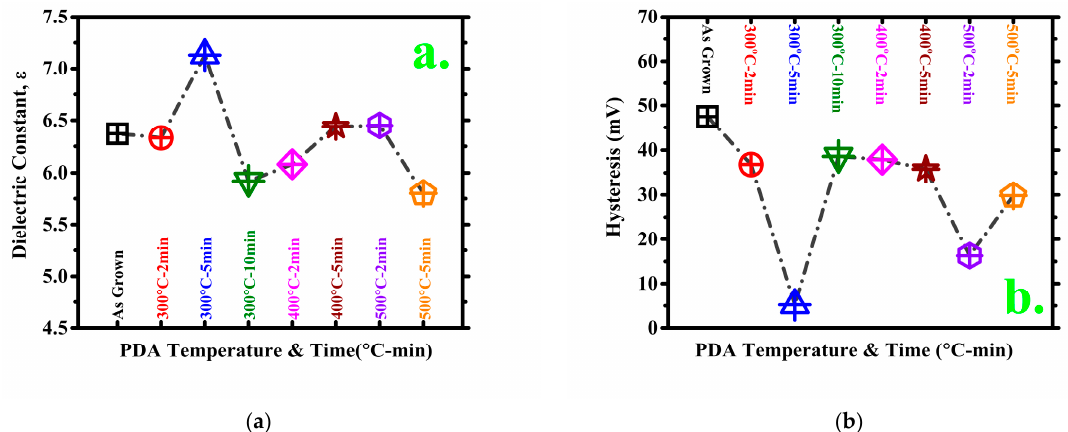
Figure 3. ( a ) Average dielectric constants; ( b ) comparison of average hysteresis. Table 2. Highest capacitance values of tested devices.